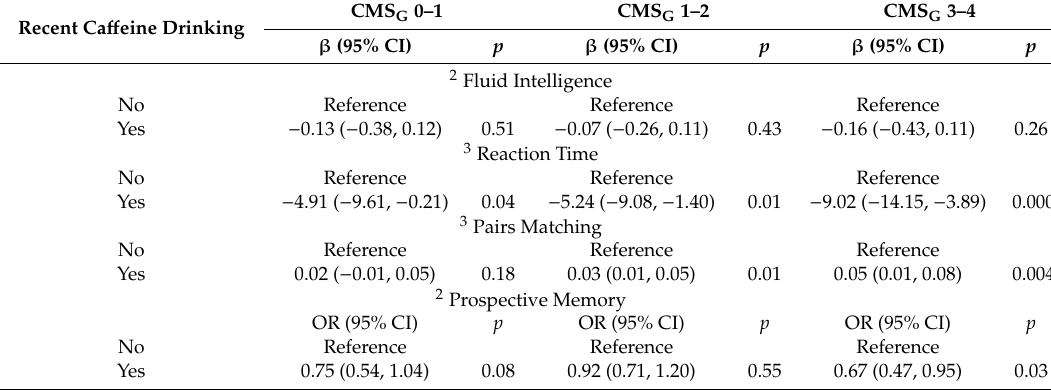
Table 4. Associations between recent ca ff eine drinking and cognitive function tests among white participants stratified by genetic ca ff eine metabolism score (CMS G ) 1